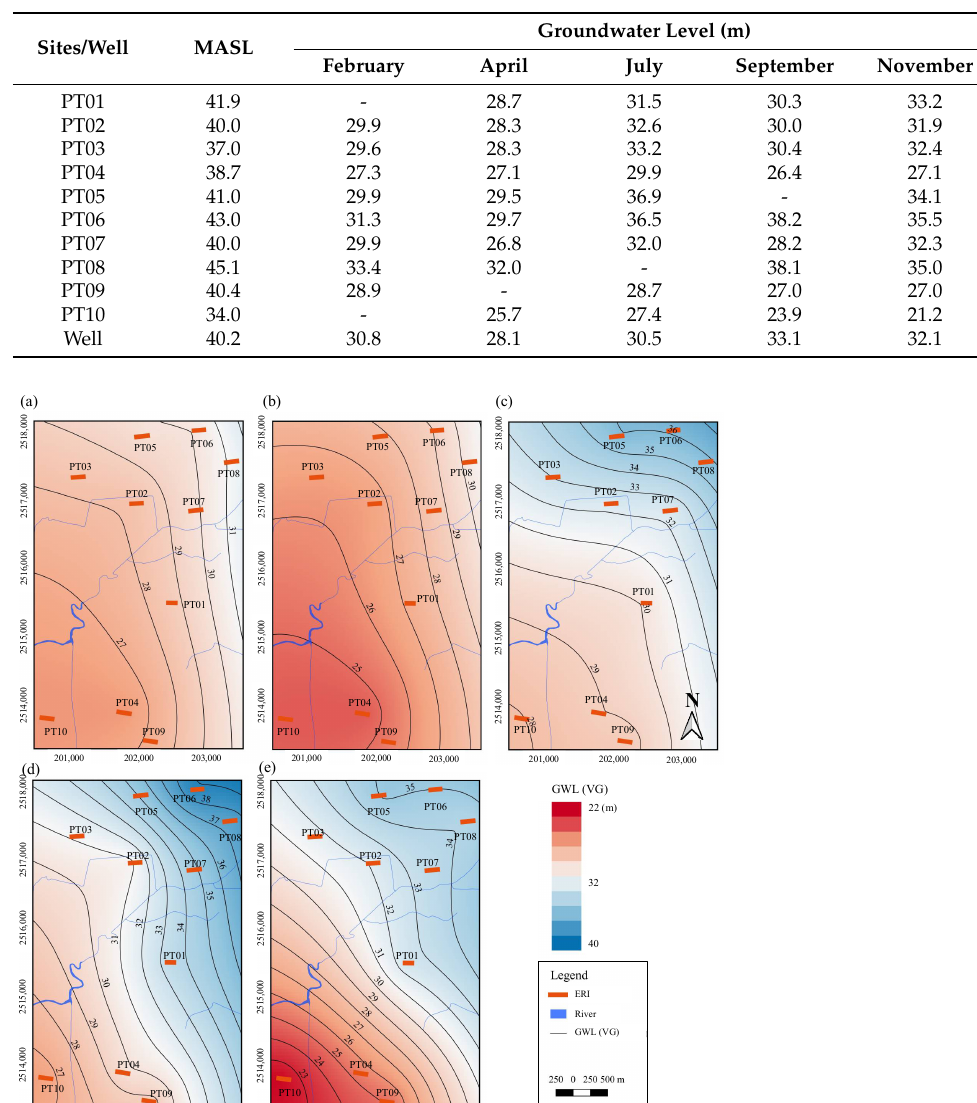
Table 4. The estimated Groundwater Level derived from Brooks–Corey (BC) for five different months of 2019.